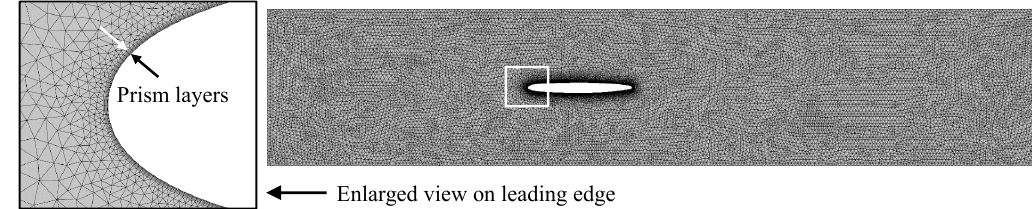
Figure 3. Schematic map of mesh elements with an enlarged view on LE.